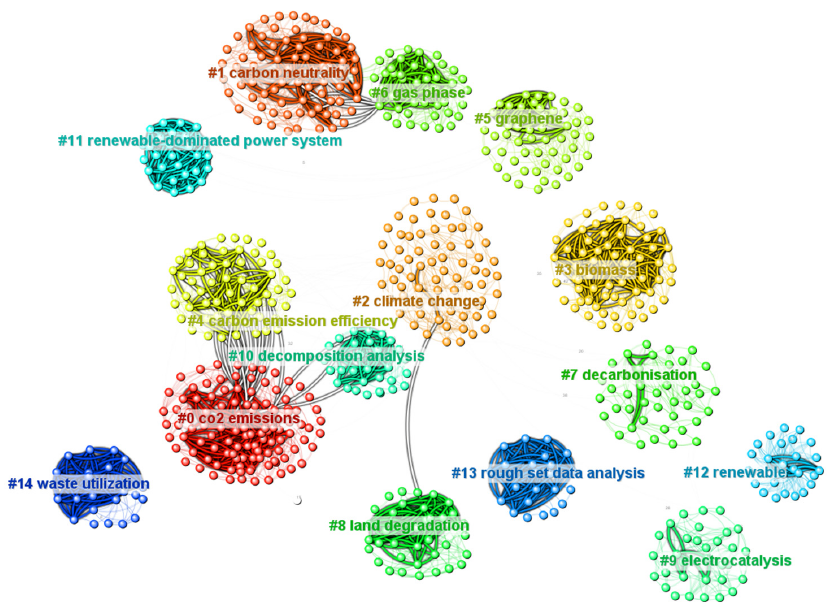
Figure 12. Graph of literature co ‐ citation.